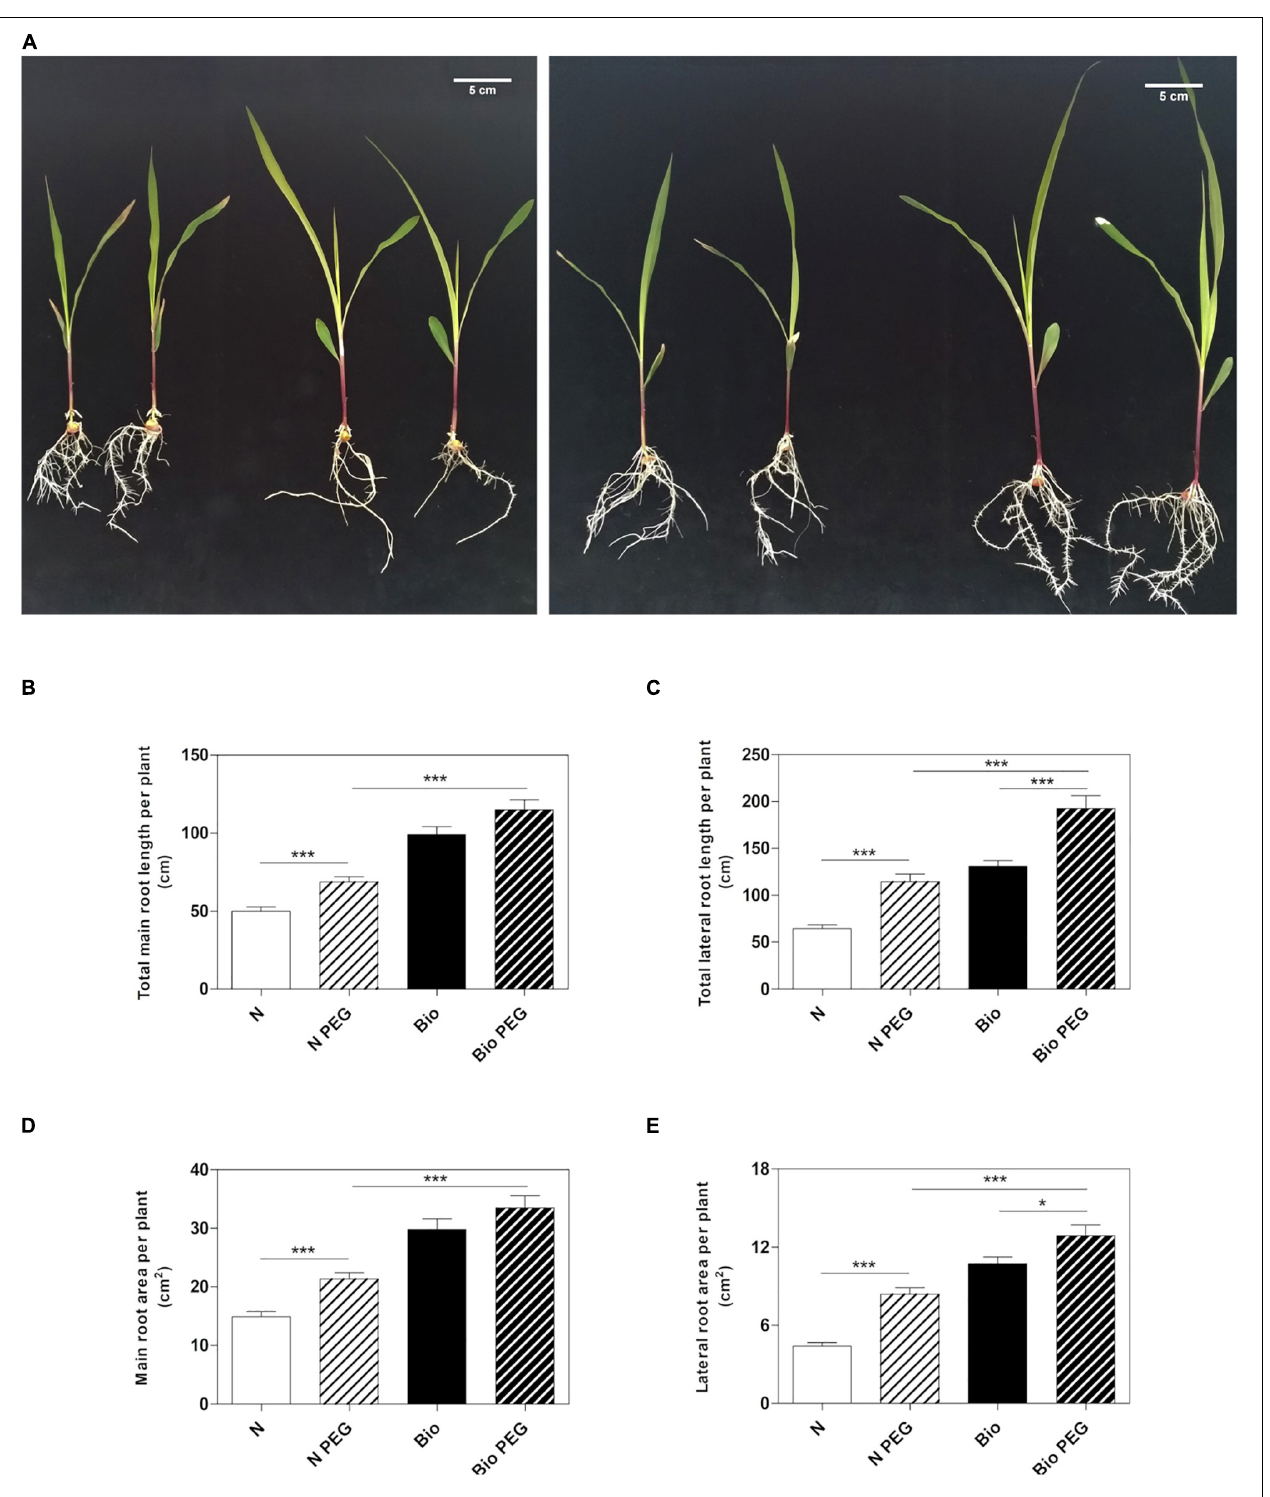
FIGURE 1 | Effects of the PH on root growth of maize plants subjected to drought stress. Maize plantlets grown with or without 15% PEG in the nutrient solution after 9 days of treatment with either 0.1 mL L − 1 PH (Bio) or with the equivalent amount of total N (14.3 mg L − 1 ), supplied as inorganic nitrogen (N) (A) . Total seminal and primary root length (B) , total lateral root length (C) , total seminal and primary root area (D) and lateral root area of the maize plantlets treated as described above (E) . Root length and root area were measured with WinRHIZOTM software. Mean values per plant are reported. Bars represent the standard error (SEM) ( n = 21), Student’s t -test was applied, * p < 0.05; *** p < 0.001.